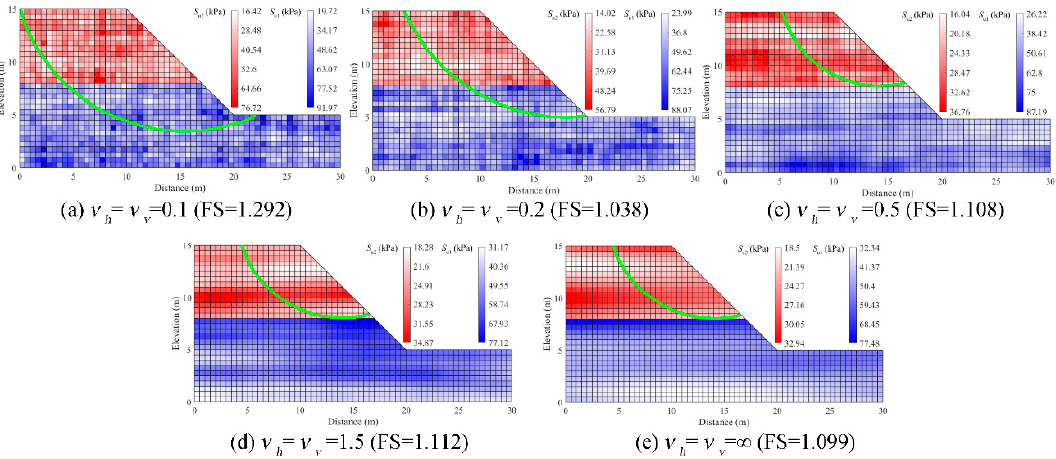
Figure 12. Typical realizations of random fields based on example Ⅰ with a different smoothness parameter, ν ( ν h and ν v denote the horizontal and vertical smoothness parameter) (color online).